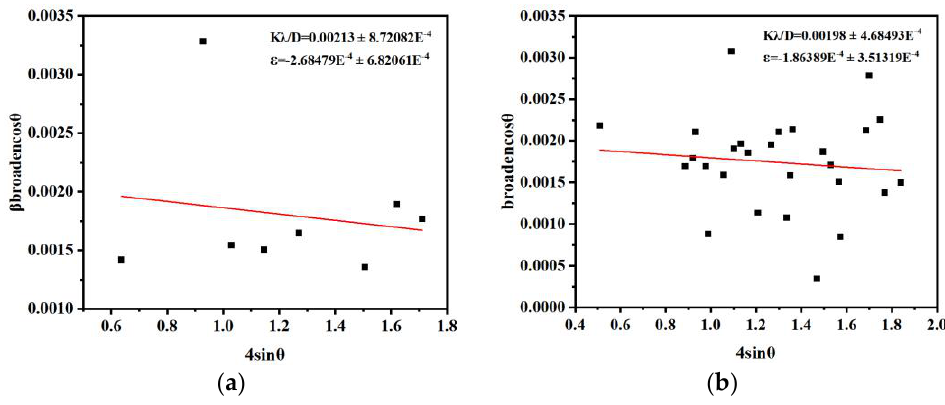
Figure 4. Microscopic strain diagram of ( a ) SnO precursor; ( b ) Sn/SnO 2.